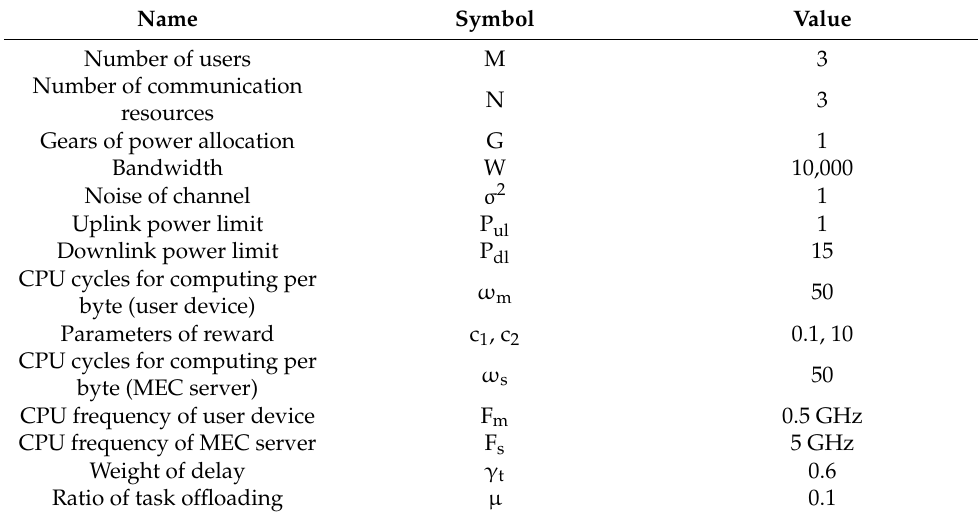
Table 1. Important simulation